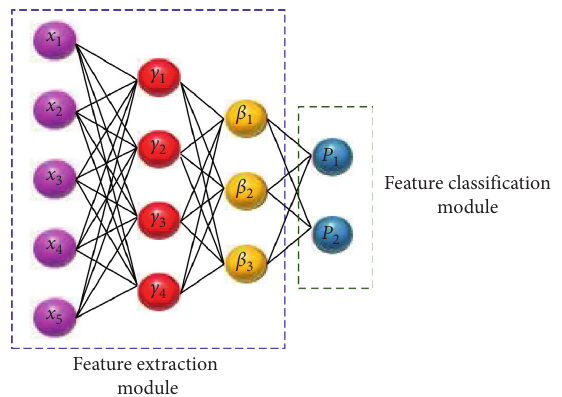
Figure 3: Feature module of the deep learning algorithm.